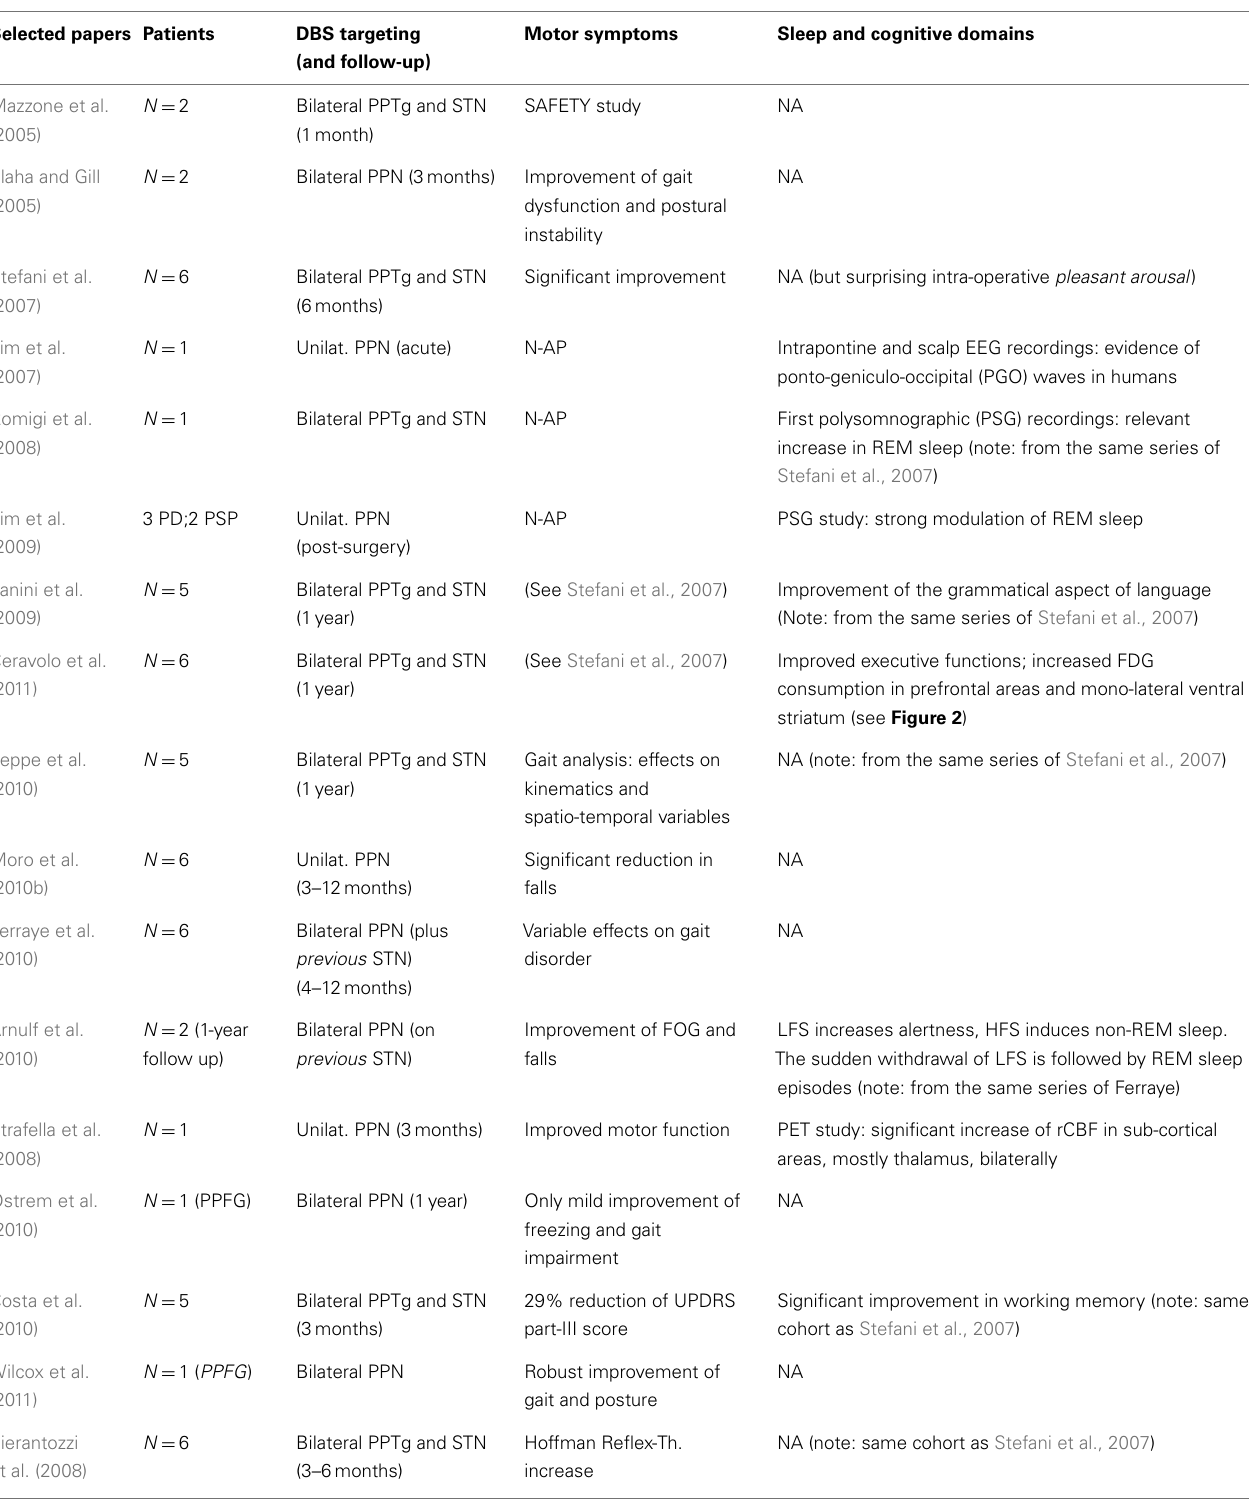
Table 1 | Selected papers on PD patients implanted in the “PPN-area” (estimated 60 patients from Rome, Bristol, Oxford, Melbourne, Grenoble,